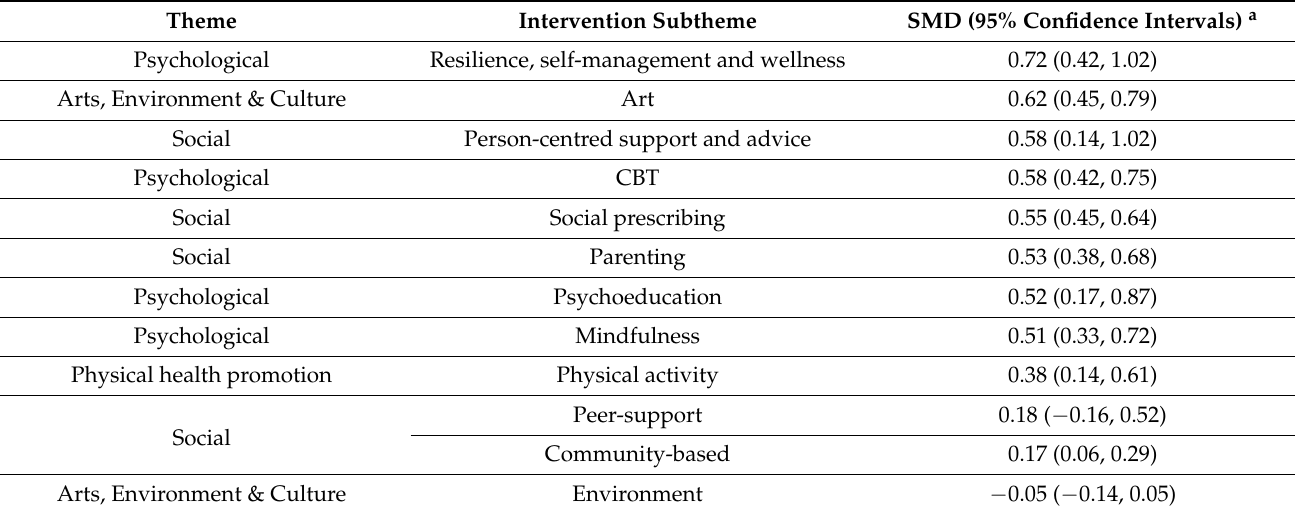
Table 2. Ranked summary of overall standardised mean difference (SMD) by intervention